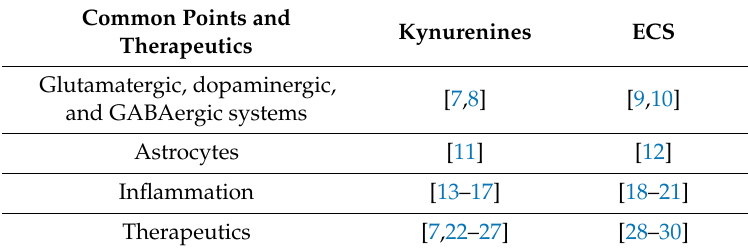
Table 1. The main studies reviewing aspects of schizophrenia that are shared by kynurenines and the endocannabinoid system (ECS). Reviews discussing the main therapeutic targets for kynurenines and the ECS relevant to schizophrenia are also indicated